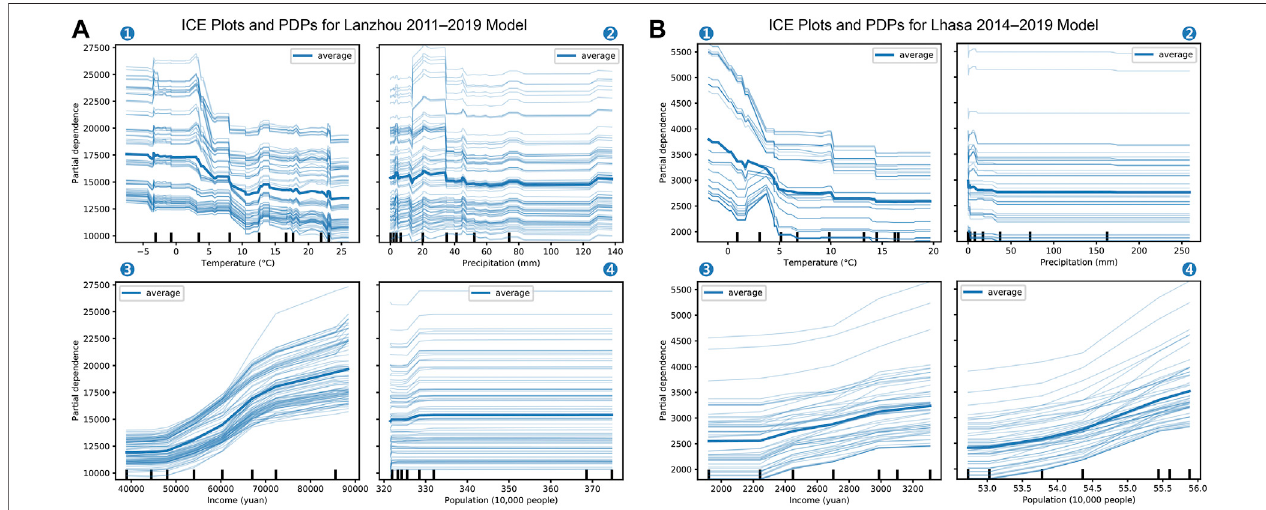
FIGURE 4 | Individual conditional expectation (ICE) plots and partial dependence plots (PDPs) for the models. Results of model estimates for REC in (A) Lanzhou during 2011 – 2019 and for (B) Lhasa during 2014 – 2019. Subplots ① , ② , ③ , and ④ show the partial dependences of temperature, precipitation, income, and population,